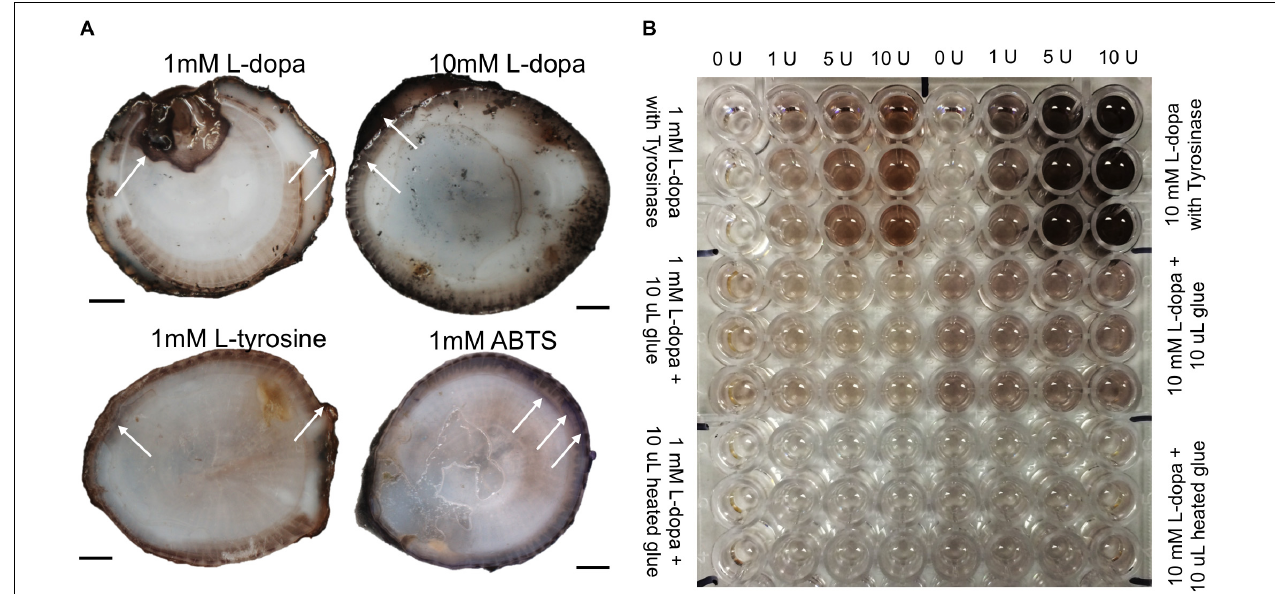
FIGURE 2 | Colorimetric enzyme-specific substrate incubated on barnacle bases (A) and with liquid glue in spectrophotometric assays (B) . (A) Arrows indicate example regions of observed color changes, L-dopa product was black (darker with higher concentration substrate), L-tyrosine product was lighter brown, and ABTS product was purple. (B) Top third of plate shows enzyme standards, run in triplicate with every assay and the corresponding units of tyrosinase added to generate the associated color change. Middle region shows liquid glue with L-dopa substrate (12 replicates for each concentration), and bottom third shows assays with heated glue. Scale bars are 1